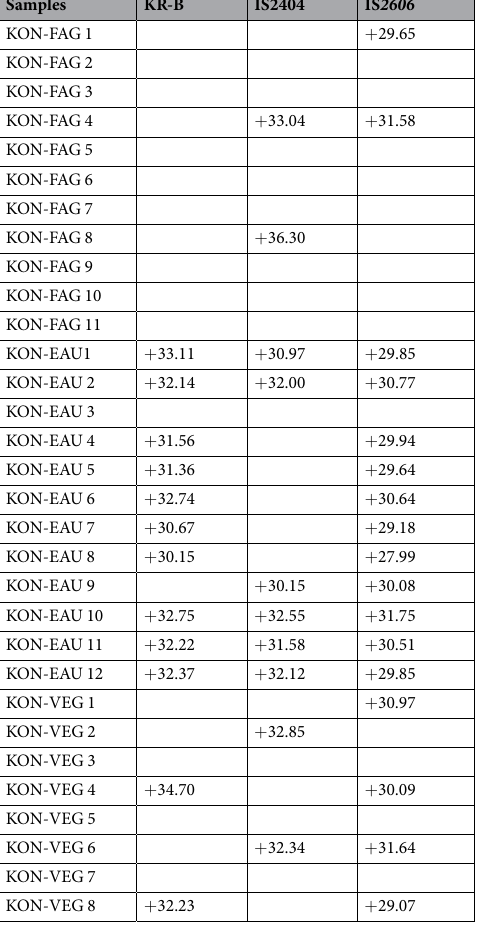
Table 1. Real-time PCR (RT-PCR) results of M. ulcerans DNA detection in aulacode feces (FAG), water (EAU) and water containing plant debris (VEG) by using detection of KR-B gene and insertion sequences IS2404 and IS2606. Ct values are indicated for specimens detected as